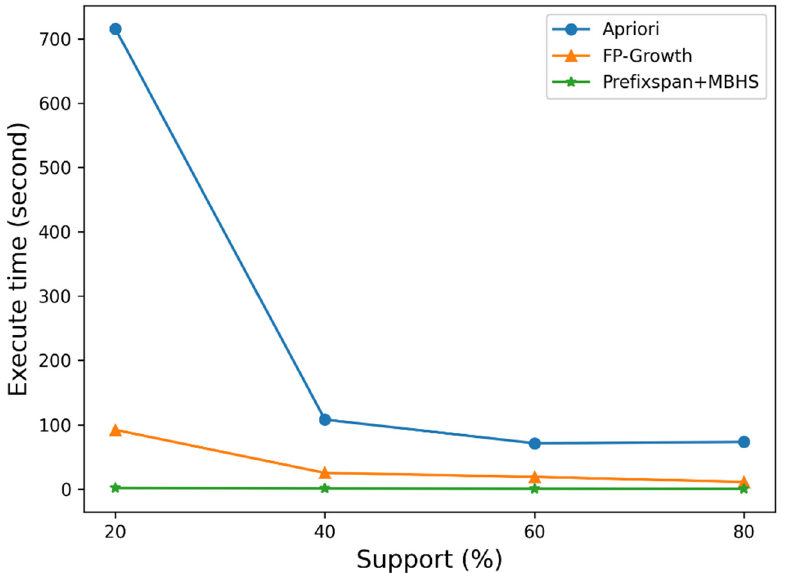
Figure 5. Comparison of the execution times of the Apriori, FP-Growth, and PrefixSpan algorithms according to the percent of support.